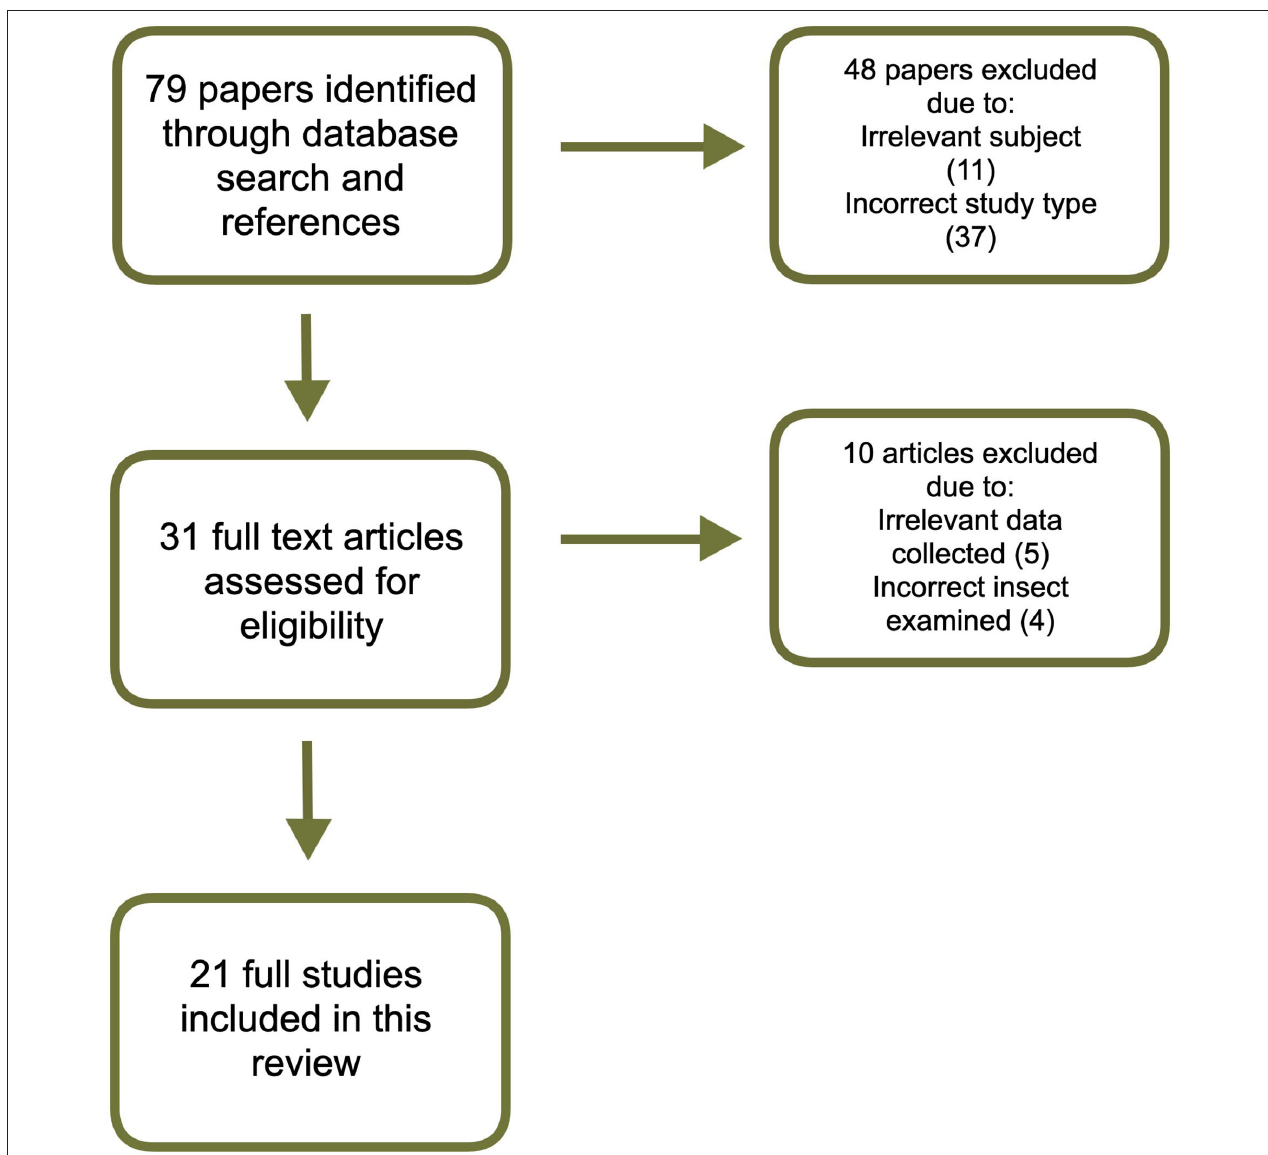
FIGURE 1 | Flowchart of the search and inclusion